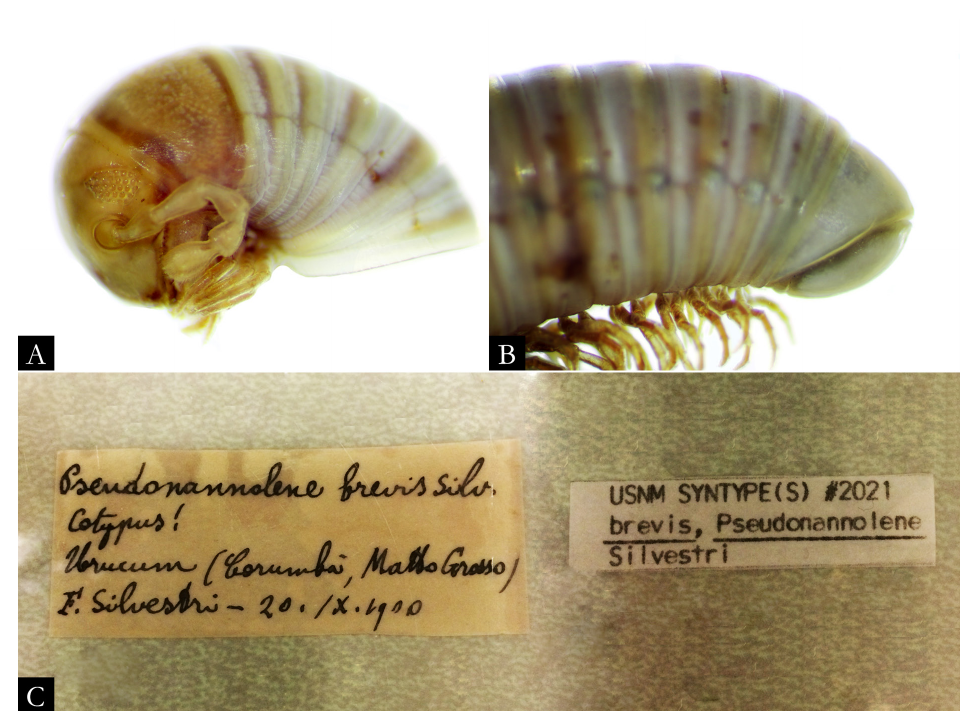
Fig. 161. Pseudonannolene brevis Silvestri, 1902, ♀ syntype (USNM 2021). A . Anterior region, in lateral view. B . Posterior region, in lateral view. C . Original label of type material. Images not to scale.